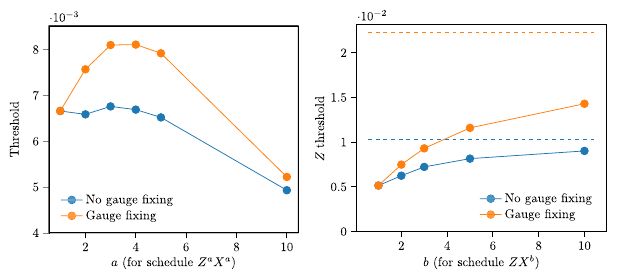
TABLE III. The mean j ¯ s j , maximum j s j , and minimum j s j max min ¯ d , maximum Δ , and minimum δ stabilizer weight and mean degree of the X -check 3D matching graphs for various homo- geneous schedules with the subsystem toric code. FIG. 13. Left: circuit-level depolarising threshold as a function a for schedules of the form Z a X a , with and without gauge fixing. Right: Z thresholds as a function of b for schedules of the form ZX b , both with (orange) and without (blue) gauge fixing, using a circuit-level independent noise model. The orange and blue dashed lines are the threshold achievable under infinite bias (using an X schedule) with and without gauge fixing, respec- tively. Error bars are smaller than the marker size and are omitted for